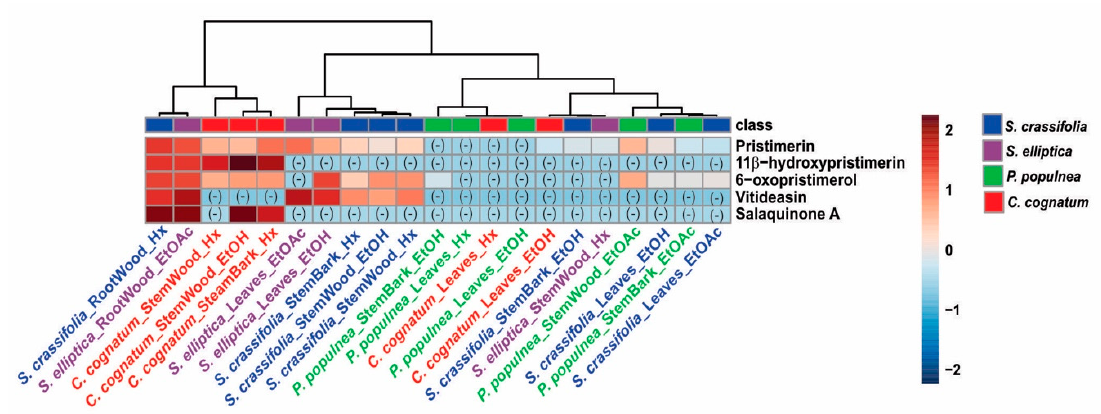
Figure 5. Heatmap and similarity analysis obtained using the MetaboAnalyst platform to analyze the metabolite profile of twenty-one different extracts from leaves, stem and root of S. crassifolia , S. elliptica , C. cognatum and P. populnea , obtained using hexane, ethyl acetate and ethanol as extraction solvents.